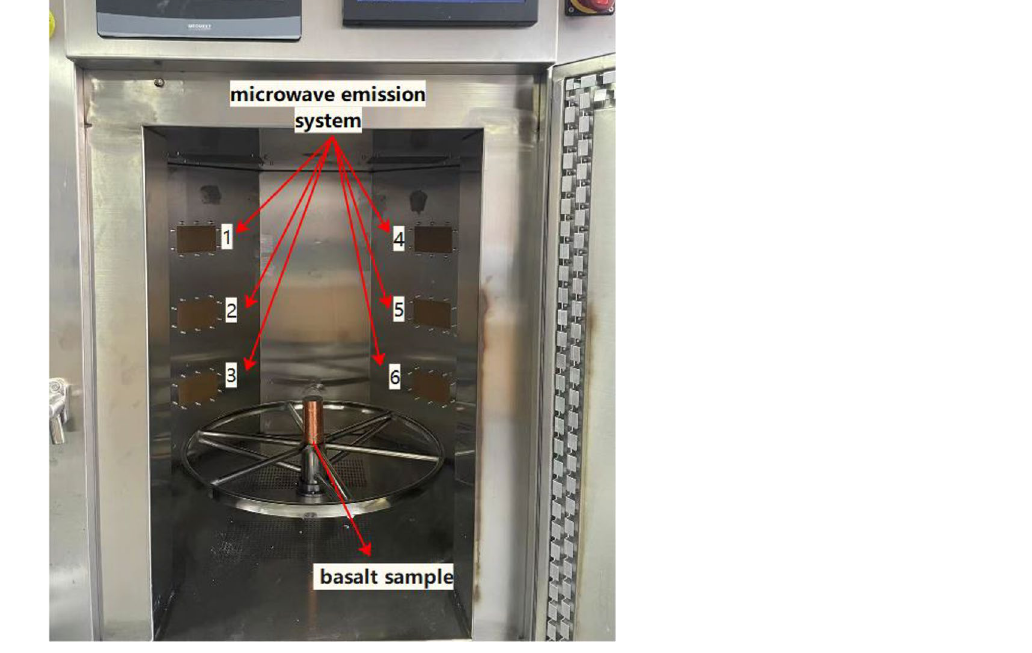
Figure 2. Multimode microwave